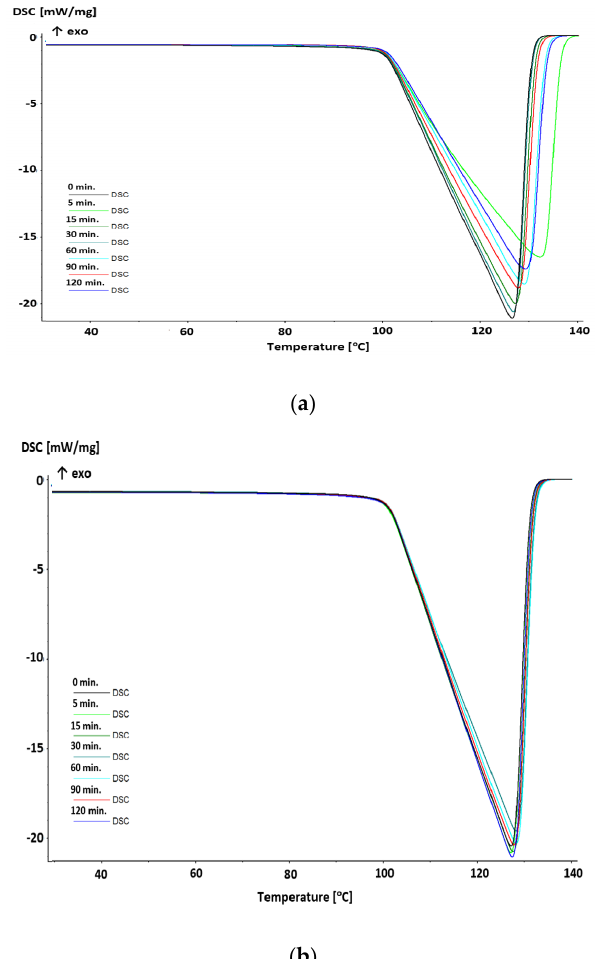
Figure 9. Differential scanning calorimetry (DSC) diagrams for tap water treated with LPGP for 0–120 min. ( a ) Diagrams for water saturated with molecular oxygen the treated with LPGP (WST); ( b ) diagrams for water treated with LPGP then saturated with molecular oxygen (WTS).